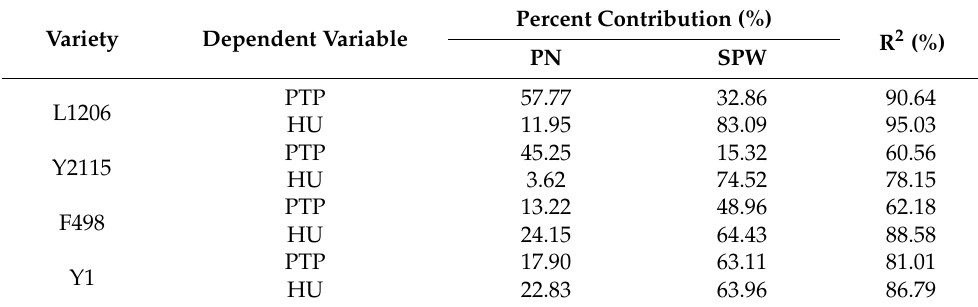
Table 7. Relative weight analysis of productive panicle number and single panicle weight on productive tiller percentage and heading uniformity in 2019 and 2020 (two-year